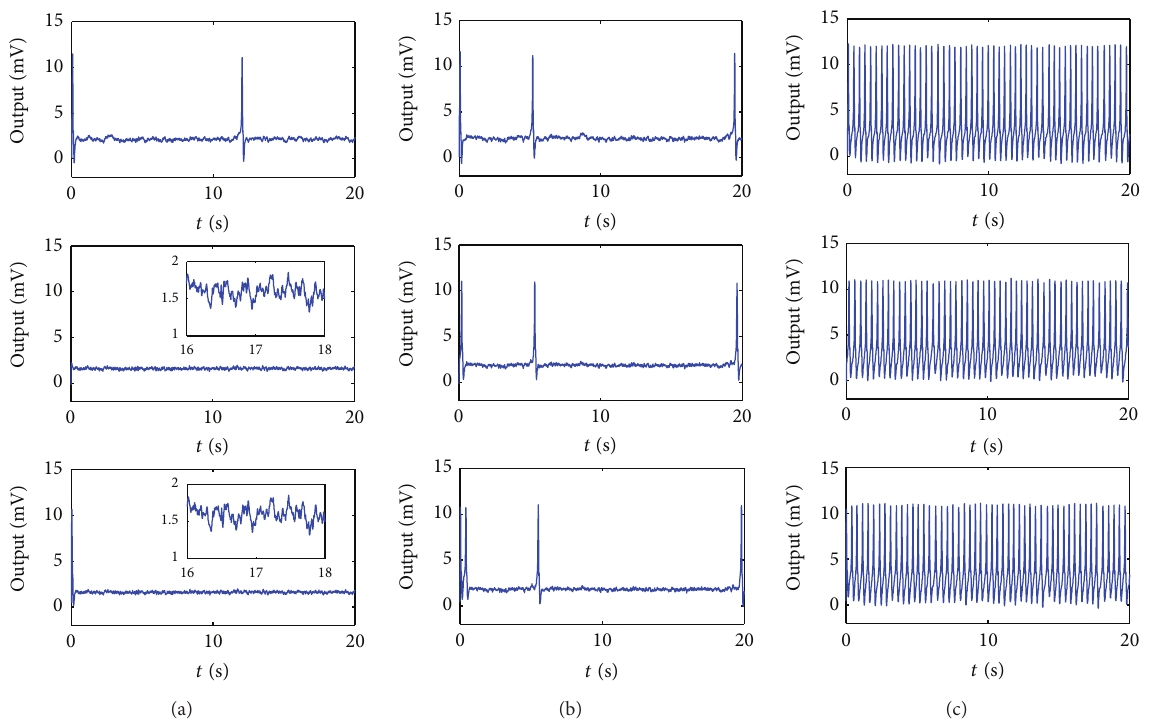
Figure 5: Simulated signals for the regular network of three coupled neural populations with different coupling strength. (a) 𝐾 12 = 𝐾 23 = = 0 . (b) 𝐾 = 𝐾 = 100 , 𝐾 = 0 . (c) 𝐾 = 𝐾 = 𝐾 = 100 𝐾 31 12 23 31 12 23 31